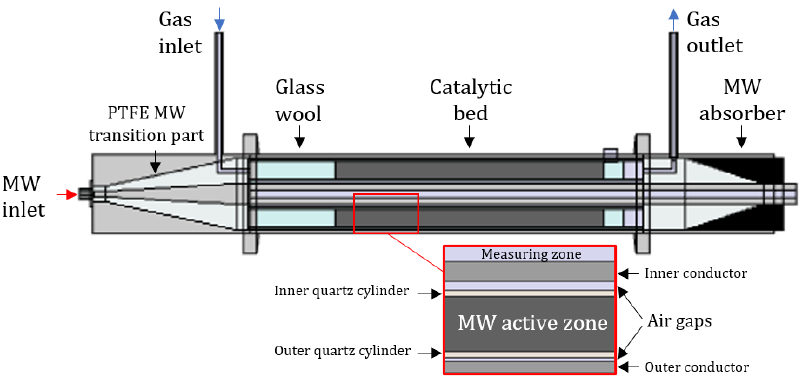
Figure 1. Representation of the axial section of the in-house built traveling-wave microwave reactors (TMR).